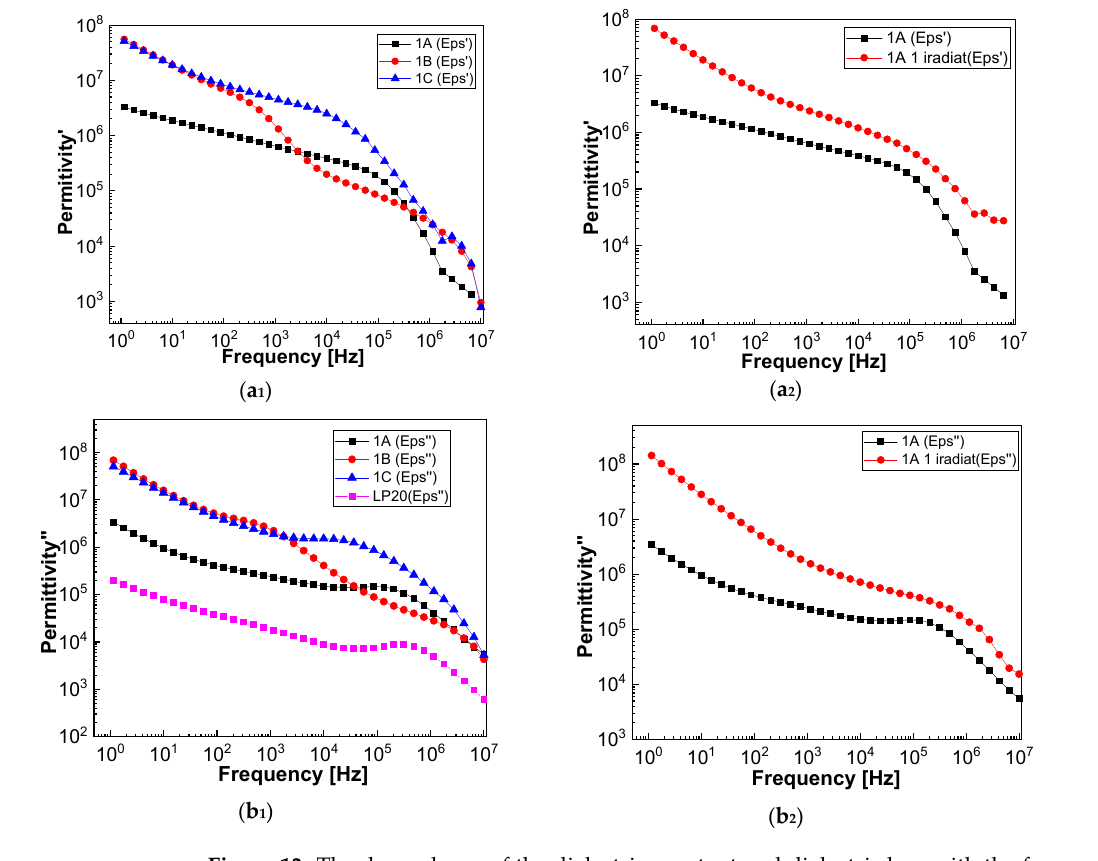
Figure 13. The dependence of the dielectric constant and dielectric loss with the frequency, in the LF range, in the case of the 1A, 1B and 1C samples as well as LP ( 1 ) before to exposure to UV light ( a 1 , b 1 ). ( a 2 , b 2 ) show the dependence of the dielectric constant and dielectric loss with the frequency in the case of the 1A sample before and after exposure to UV light (labelled as 1A1).